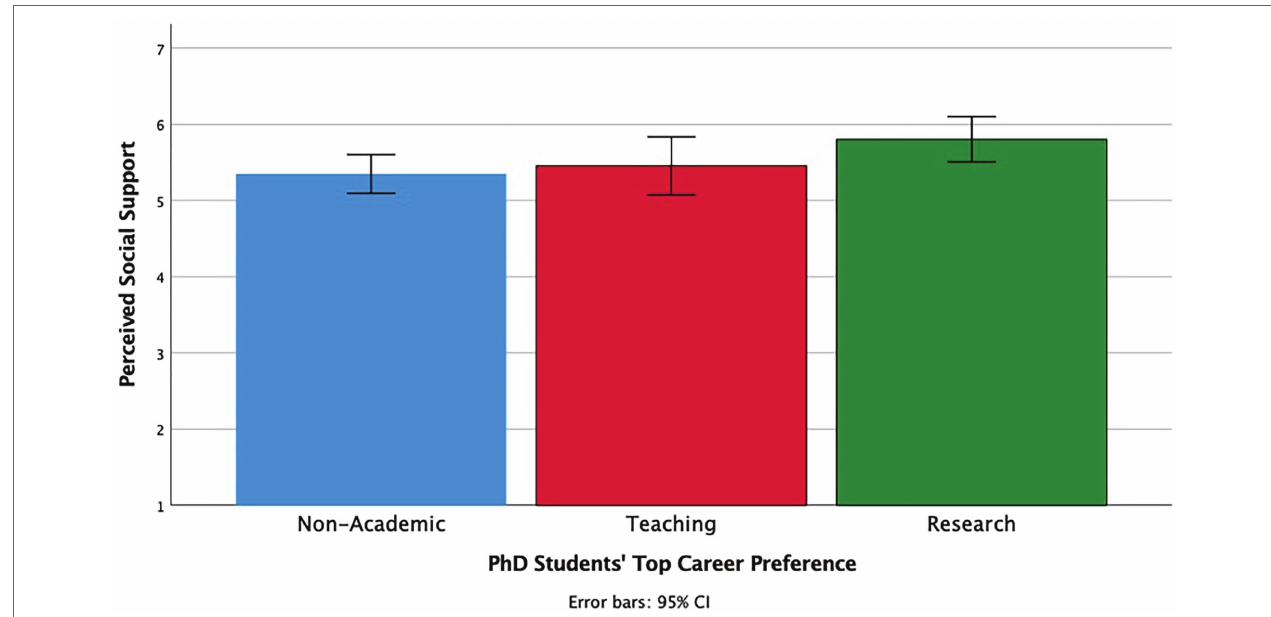
FIGURE 4 | The relationship between PhD students’ own career preference and perceived social support within the